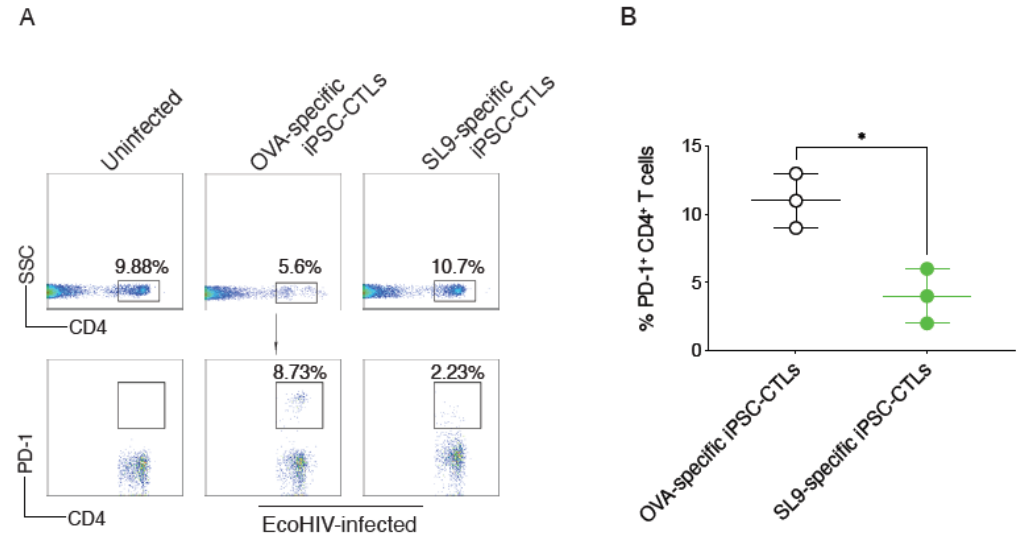
Figure 6. Adoptive transfer of SL9-specific iPSC-CTLs suppress PD-1 expression on CD4+ T cells. HHD mice were i.v. adoptively transferred with SL9 or OVA 257 – 264 -specific DsRed + CD8 + pre-iPSC-CTLs and in the following week were i.p. infected with EcoHIV. Eight weeks after EcoHIV infection, single cell suspensions were made from the spleens. ( A ) Expression of PD-1 on CD4 + T cells was determined by flow cytometry. Data shown are the representative of three identical experiments ( n = 5). ( B ) Quantification of PD-1 + CD4 + T cells. The values represent mean ± S.E.M. (* p < 0.05, Unpaired t test).